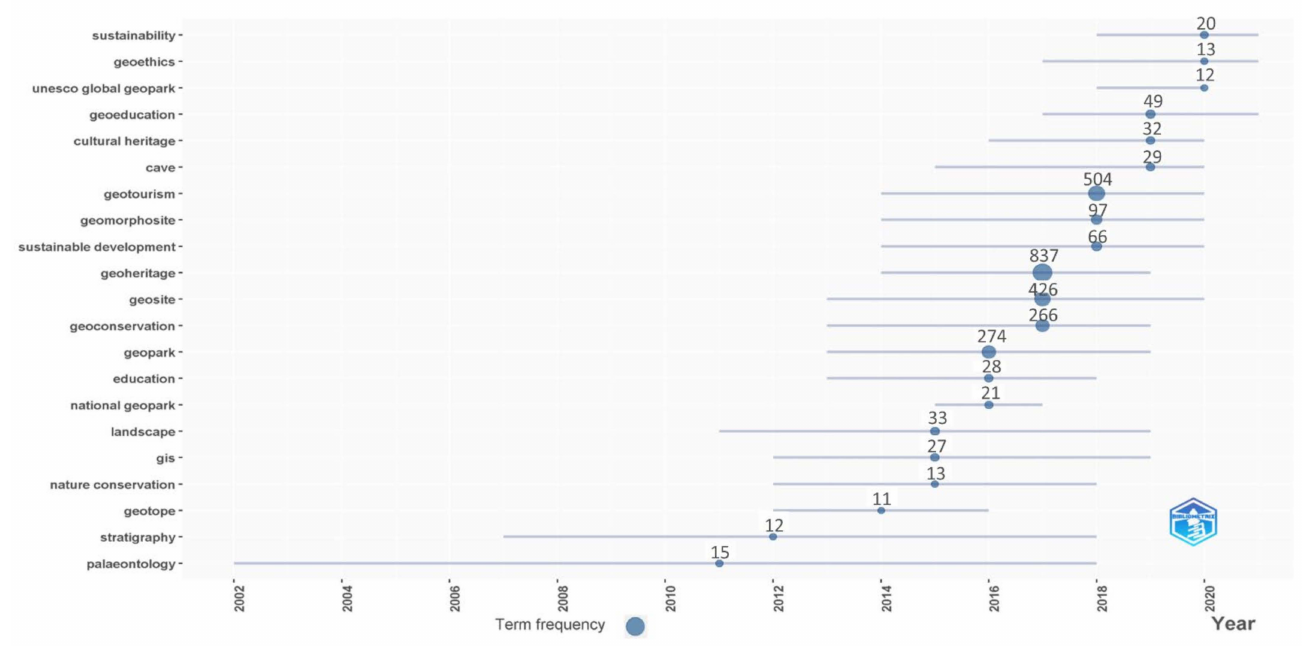
Figure 8. Trending topics during the geoheritage study